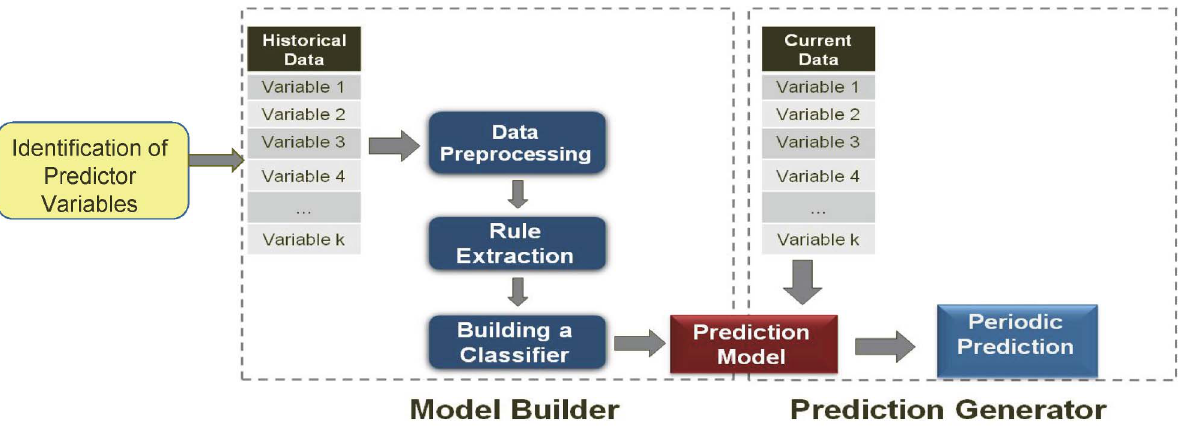
Figure 3. Dengue prediction method.